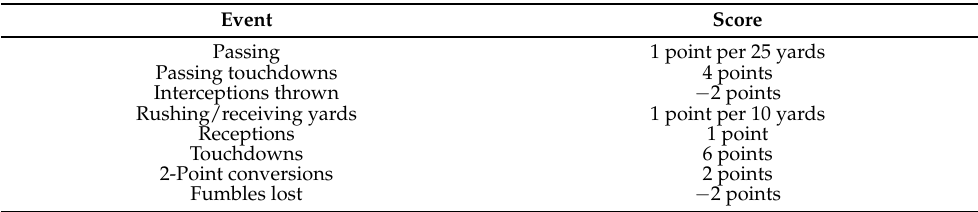
Table 5. List of points given in fantasy football’s PPR scoring.